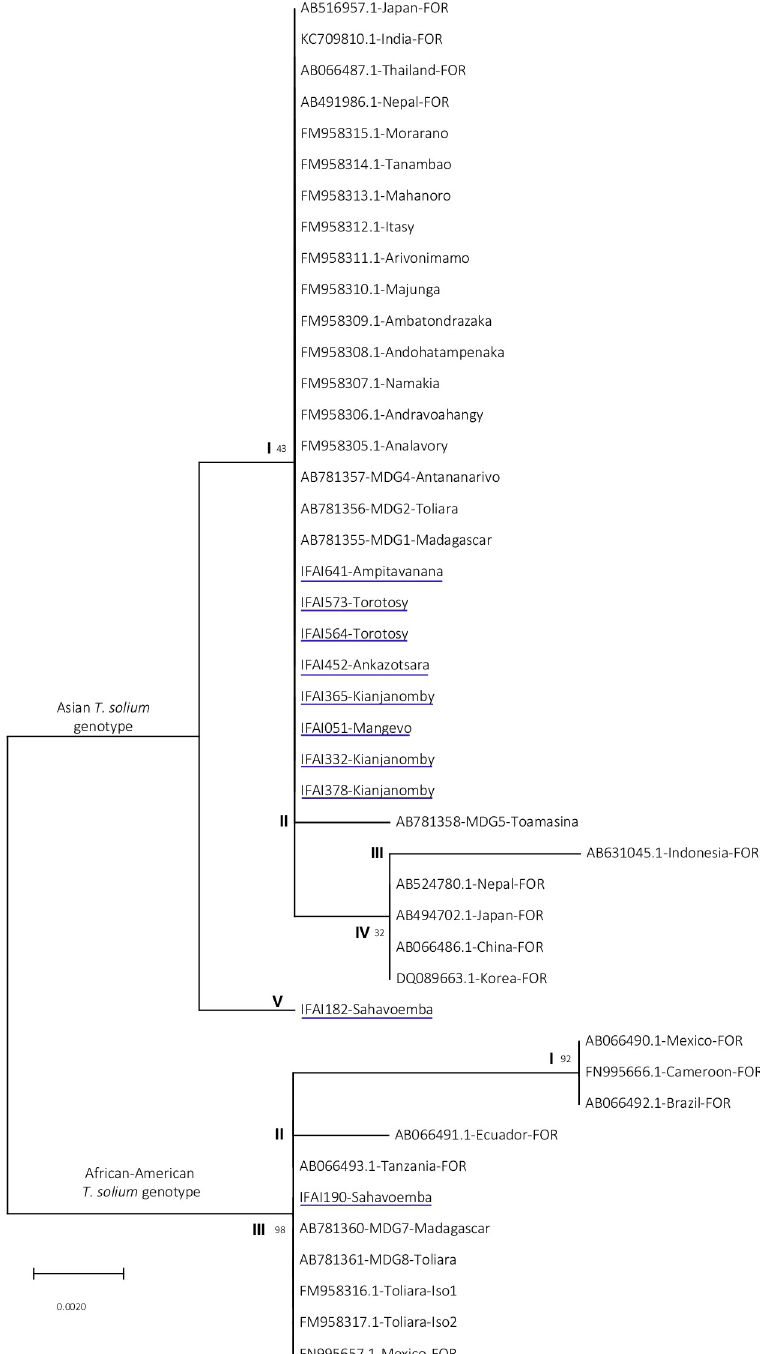
Fig 3. Phylogenic tree showing the Asian and the African-American Taenia solium genotypes of the specimens obtained in this study and in databases. Cox1 sequences obtained in this study (from human stool with detected Taenia eggs) are underlined in blue. The sequences obtained from EMBL/Genbank databases (from cysticerci of pig) are indicated with their accession numbers followed by the name of each District/township for genes described in Madagascar and by “FOR” for specimens collected in foreign country. The percentage (%) of bootstrap replicates for the reliability tests of the associated taxa clustered together is shown next to the branch (up and down for the genomic and coding forms